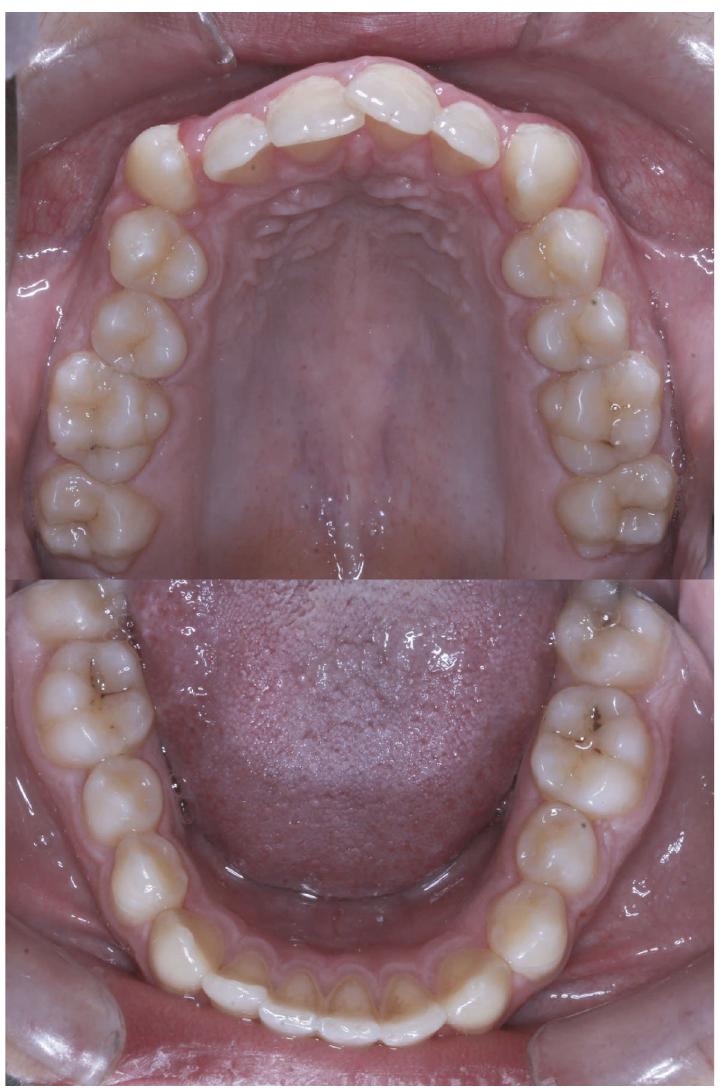
Figure 1: The lingual view of all teeth, showing no signs of any abnormalities.